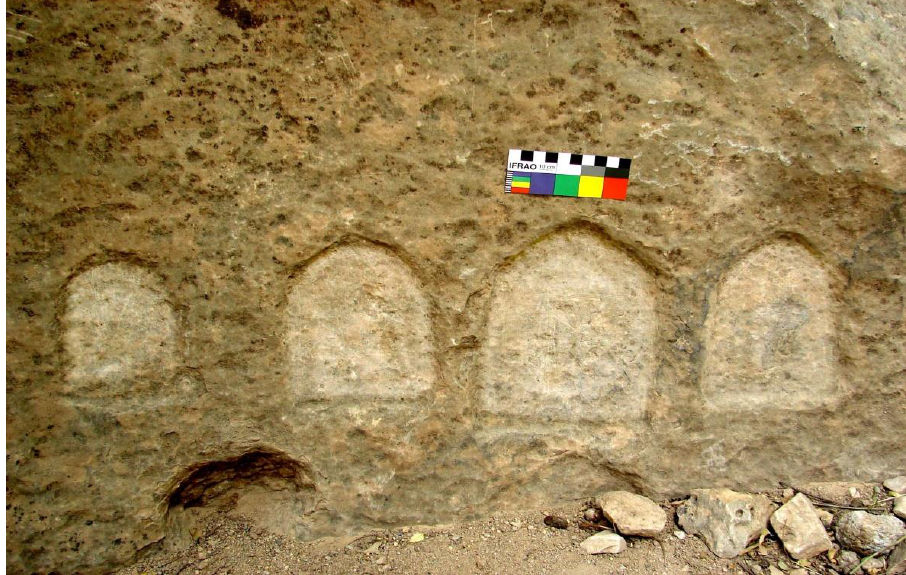
Figure 9. Four small geometric shapes, which were probably made during Historic or Islamic